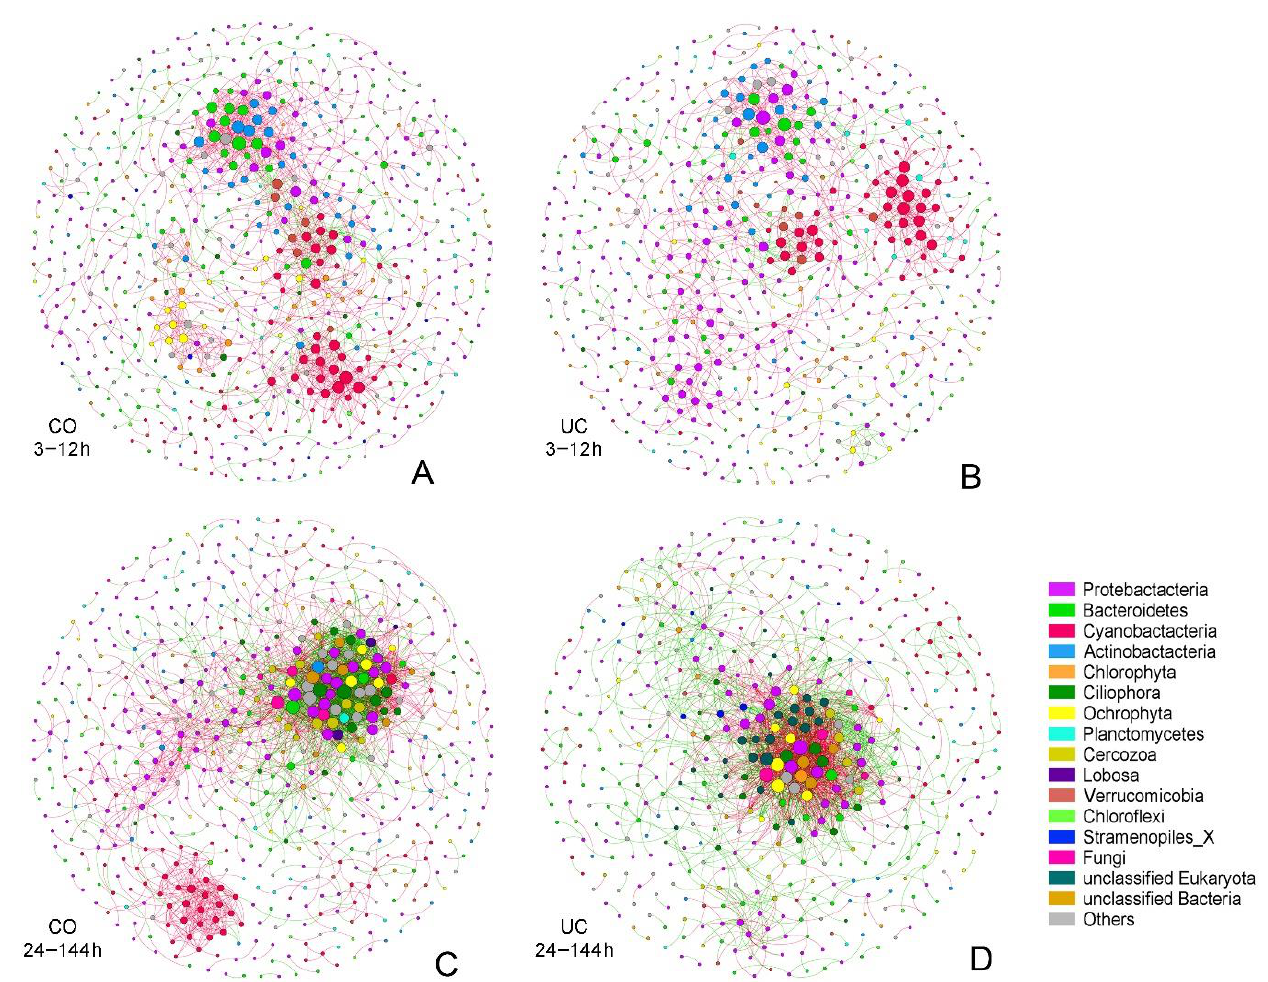
Figure 5. The networks visualizing the OTUs interactions in different groups (( A ) 3–12 h in CO group; ( B ) 3–12 h in UC group; ( C ) 24–144 h in CO group; ( D ) 24–144 h in UC group). The nodes are colored according to the phylum classification, and the size of each node represents the node degree. Each node corresponds to an OTU, and the edges between nodes correspond to positive (red) or negative (green) correlations. CO: with lid closed, UC: without